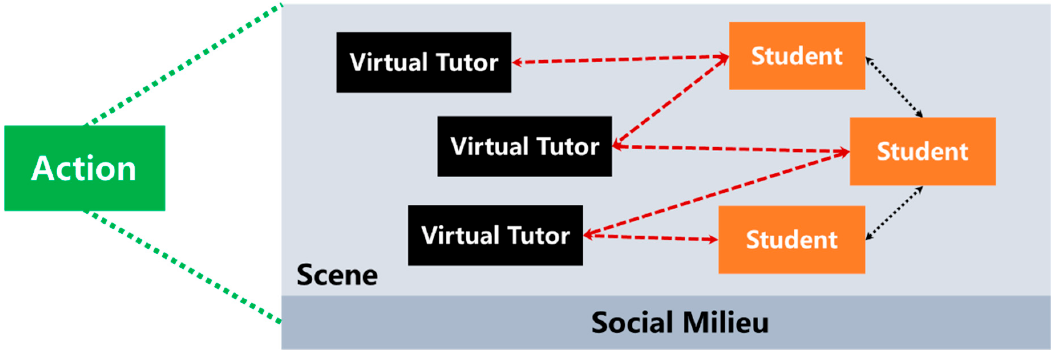
Figure 6. Action module constructs an immersive scene for students with multiple virtual tutors.